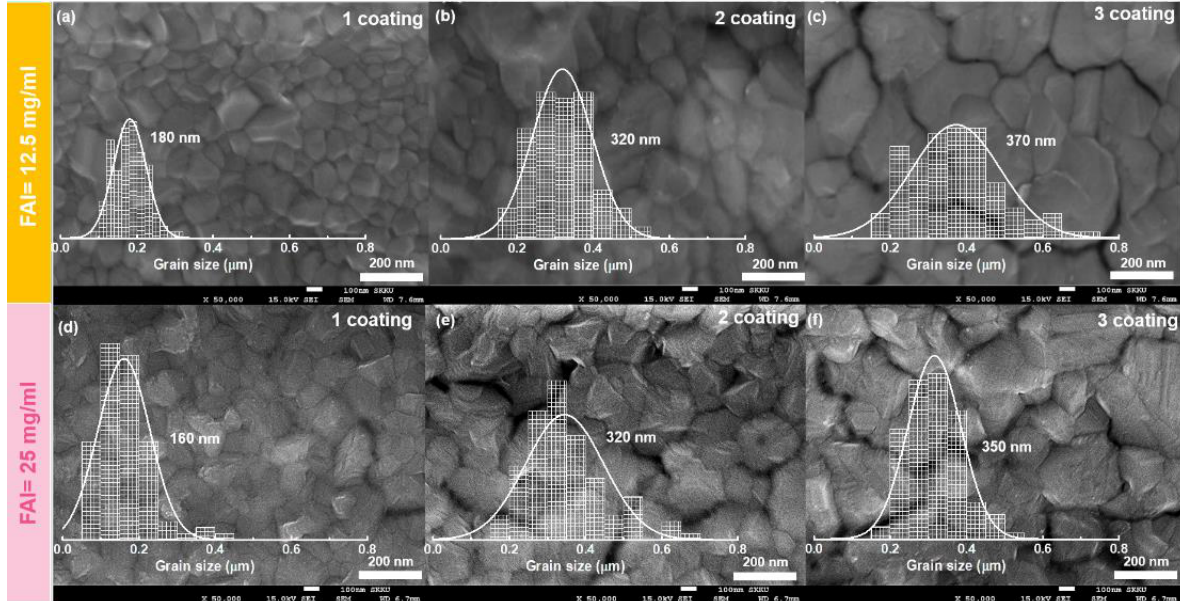
Figure 2. SEM images and grain-size distribution of FA x MA 1 − x PbI 3 films with 12.5 mg/mL FAI after ( a ) 1, ( b ) 2, and ( c ) 3 coatings and with 25 mg/mL FAI after ( d ) 1, ( e ) 2, and ( f ) 3 coatings. The scale bar is 200 nm.